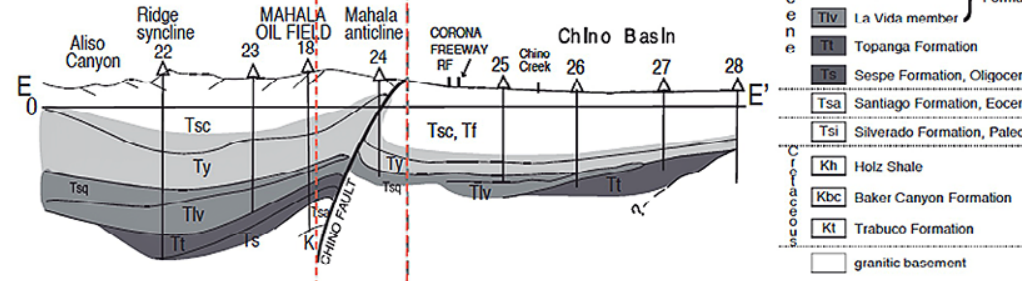
Figure 4. Cross-section of Chino fault study area for line E-E’ of Figure 3 (Madden & Yeats,